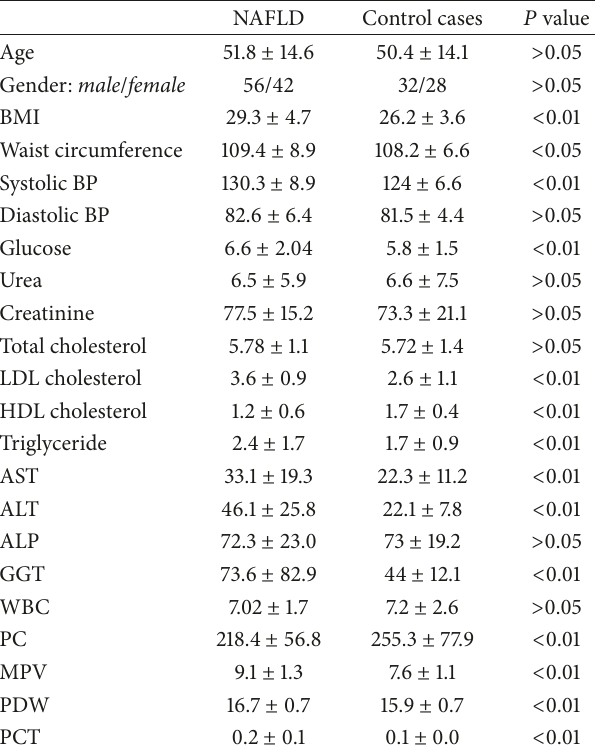
Table 3: Clinical, laboratory, and demographic data of NAFLD patients compared to controls.